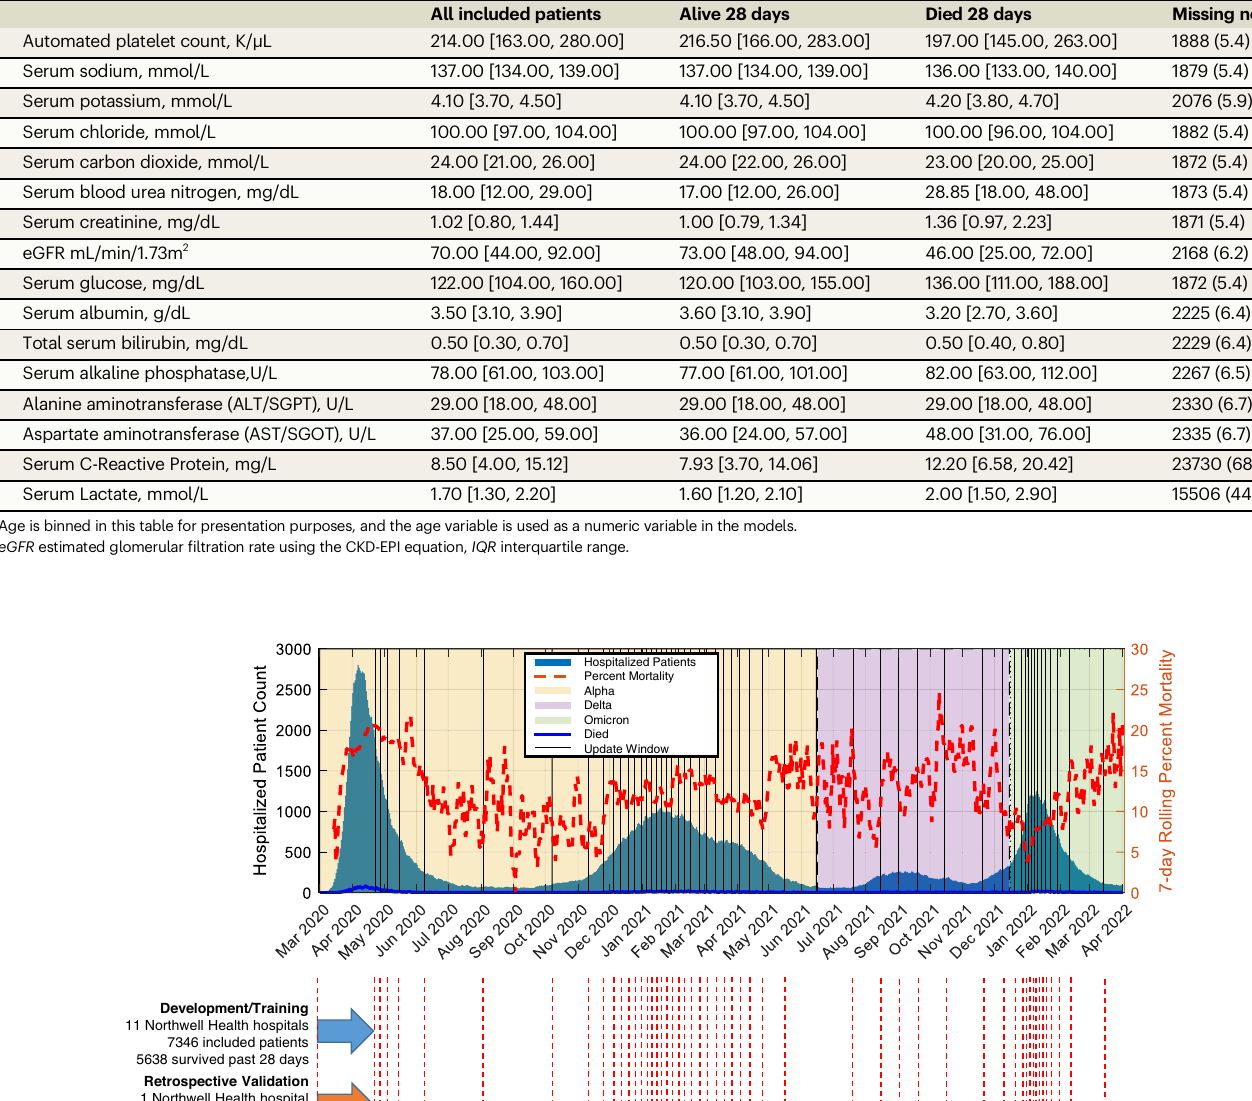
line. The three different dominant variants (alpha, delta and omicron) are repre- sented as background colors). The vertical dashed red lines indicate the left edges of the 2000 patient sliding window that increments by 500 patients at a time. NOCOS Northwell COVID-19